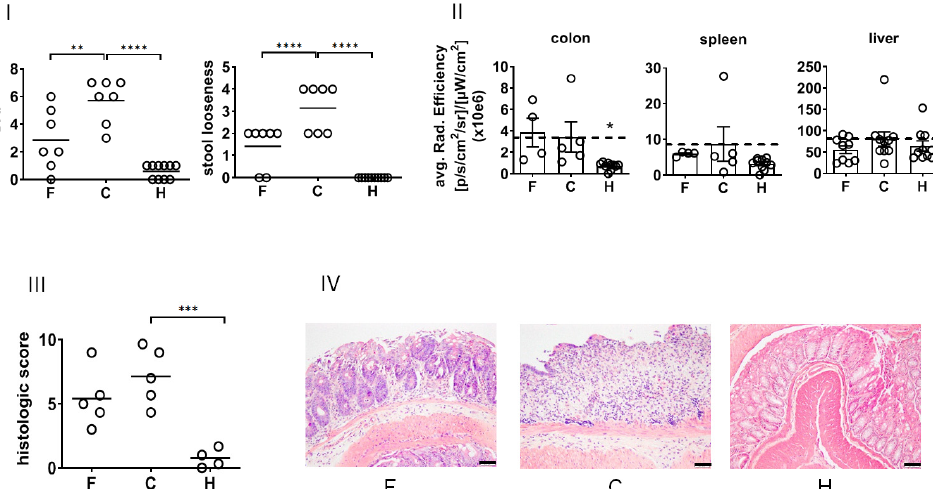
Figure 4. Impact of NPs on clinical and histopathological features of the DSS model of colitis in mice at recovery day 4. ( I ) Clinical features. ( II ) Ex vivo macroscopic organ imaging of pan-cathepsin activity as determined via near-infrared optical imaging after excision from animals (for details, see Methods). ( III ) Histopathological scoring of damages in the mucosa and submucosa (see Methods for scoring procedure) on the basis of HE-stained histological slides from the colon. ( IV ) Representative microscopic pictures of the colon (HE staining, scale bars: 50 μ m). F—NPs in animals with colitis, C—colitis only (no NPs), H—healthy animals (no NPs). Mean ± SD; n = 5 to 7. Significant difference compared to group C with p < 0.05 (*), p < 0.01 (**), p < 0.001 (***), and p < 0.0001 (****).